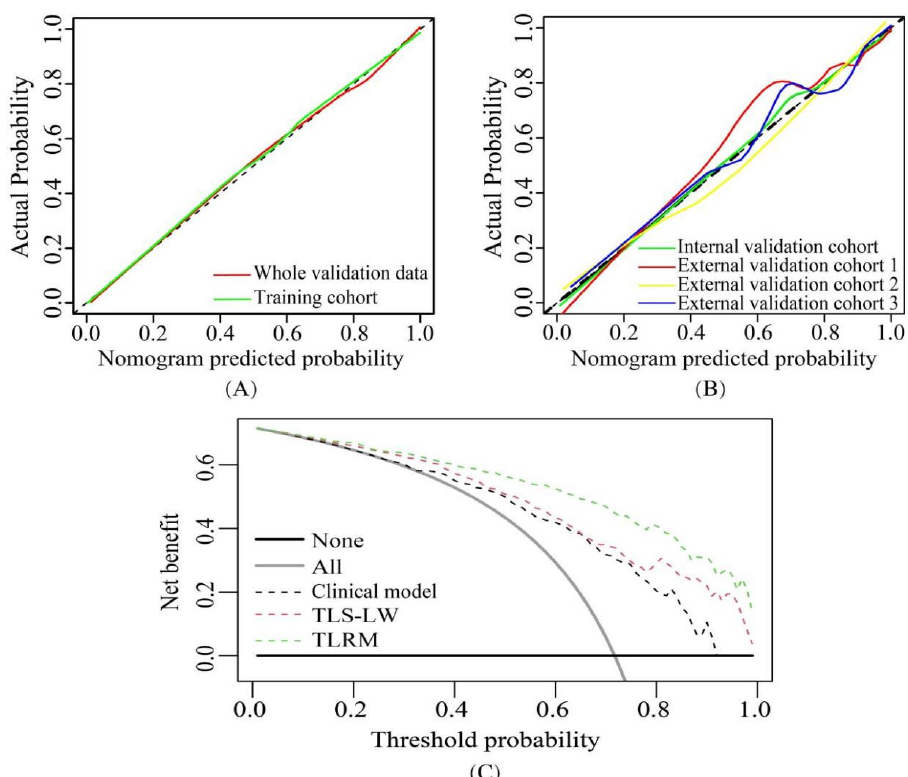
Figure 6. Calibration curves and decision curve analysis. ( A ) The calibration curves of TLRM in the training cohort and whole validation data. ( B ) The calibration curves of TLRM in the four validation cohorts. ( C ) Decision curve analysis of the clinical model, TLS-LW, and TLRM in whole validation data. The results showed that the net benefit of TLRM was greater than that of the clinical model and TLS-LW (range, 0.01–1.00). Note: TLS-LW, transfer learning signature based on lung cancer WSI; TLRM, transfer learning radiomics model.